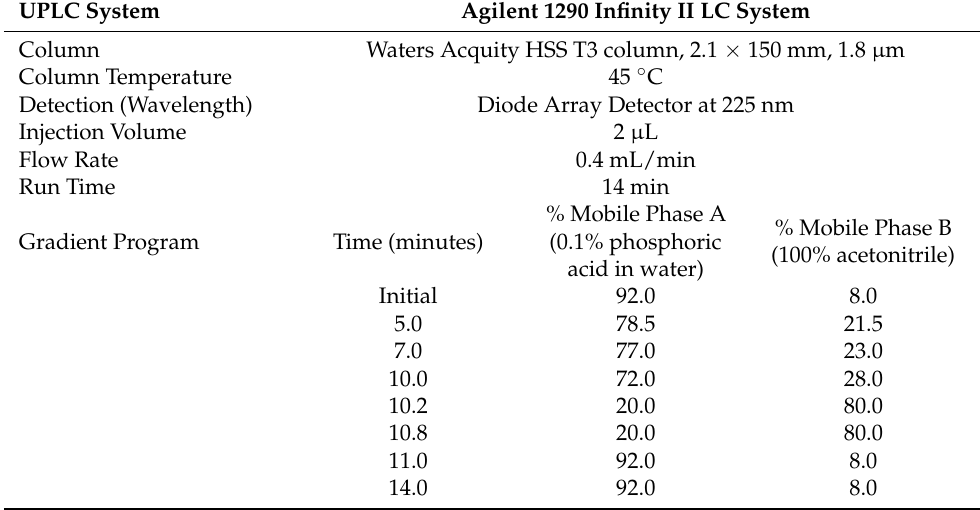
Table 2. The final instrument